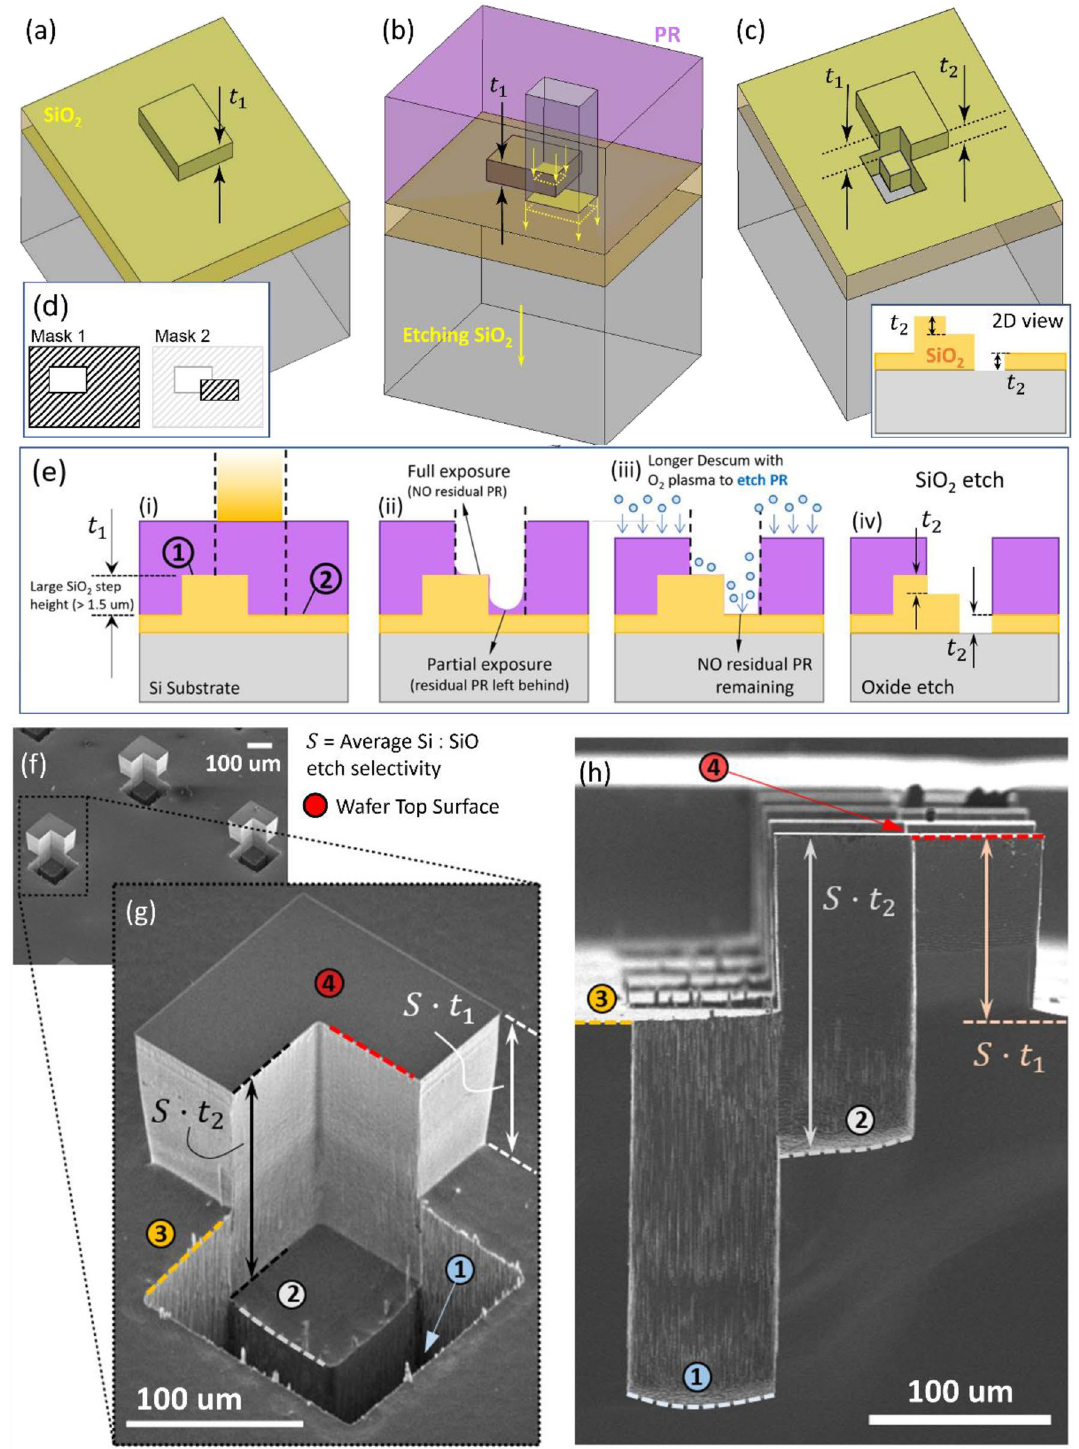
Figure 5. Overlapping mask designs to make complicated structures . ( a ) First mask design (as shown in ( d )) is exposed and SiO 2 is etched by t 1 amount; ( b ) Second design overlaps partially on the step made in step ( a ) and ( c ) SiO 2 etch is performed to obtain a 3-level 3D feature on the SiO 2 . A 2D counterpart of this 3-levels structure is shown in ( e —iv) ( d ) The two masks for two rounds of ‘litho + SiO 2 etch’ are shown, image on the right shows how the masks overlap. ( e ) It has been verified that steps up to 1 μm in SiO 2 do not affect the exposure process. In case the step height is ≥ 1.5 μm, there could arise differences in exposure quality between the two levels of SiO 2 , 1 and 2. In this situation the lower steps might be underexposed, with PR being left behind—a longer downstream descumming step (≥ 2 min) fixes the issue, by removing all of this residual PR. ( f ) After DRIE, the structure is scaled vertically and transferred to the underlying Si, and the new 3-level pin–fin–hole combination arrays are shown; ( g ) zoomed view of the 3D structure; ( h ) side cross-sectional view. The numbers represent the different